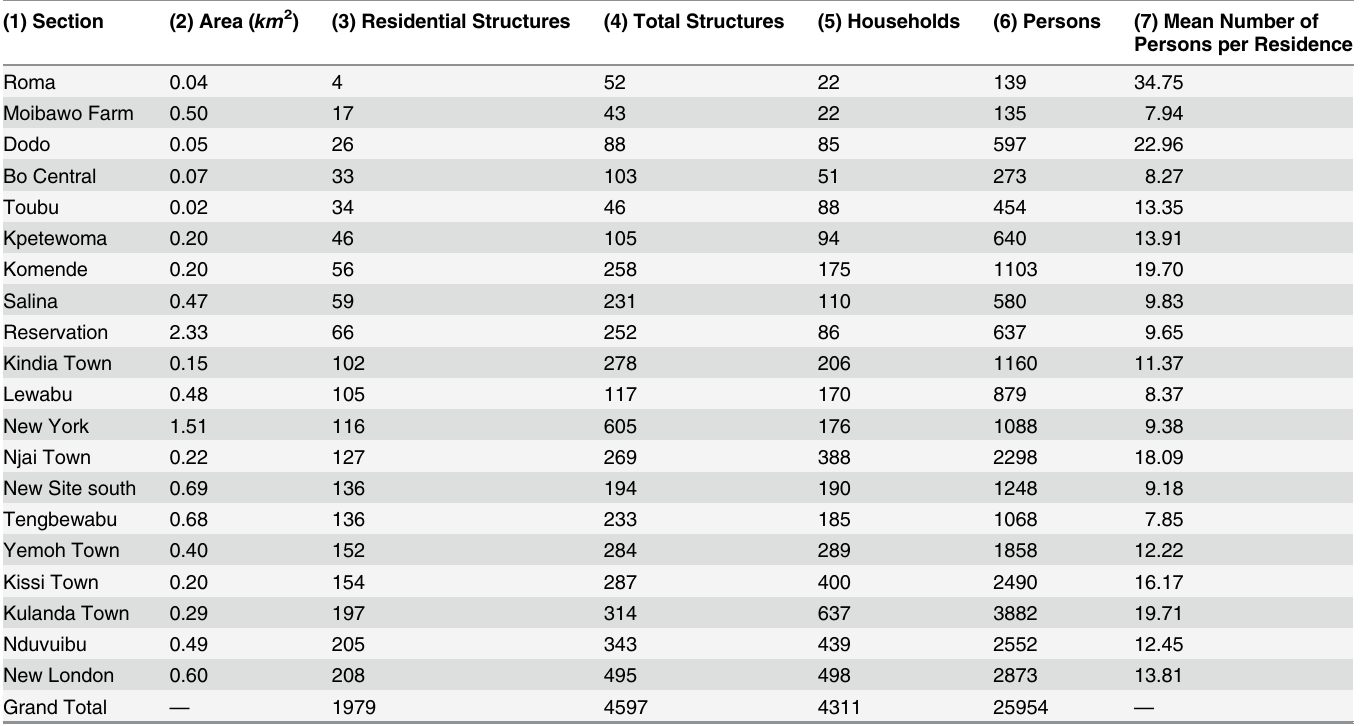
Table 1. Bo municipal survey data tabulated by